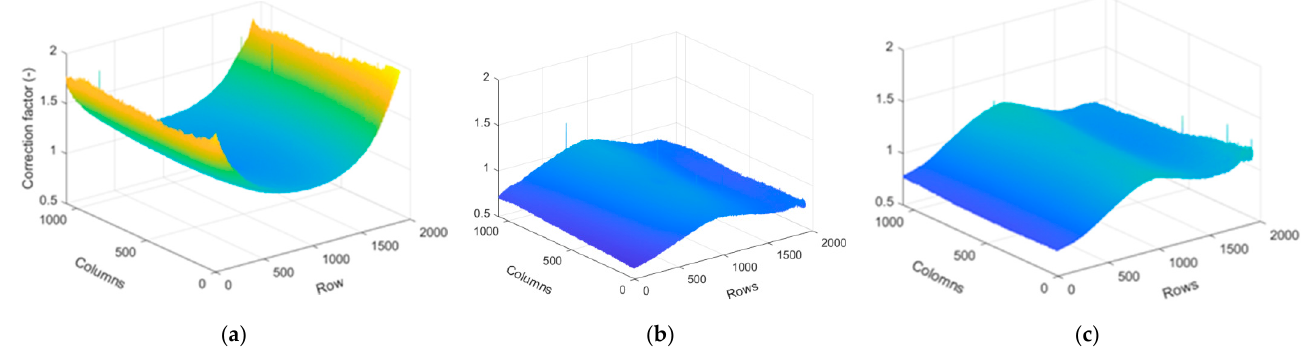
Figure A1. Correction factors for: ( a ) the NIR, ( b ) R and ( c ) G bands. Minimum (min), maximum (max), range of variability (range) and mean statistics characterizing the correction factors images were: for the NIR band: min–max: 0. 9259– 2.2371 (range: 1.3112), mean: 1.2157; for the red band: min–max: 0.6047–1.3787 (range: